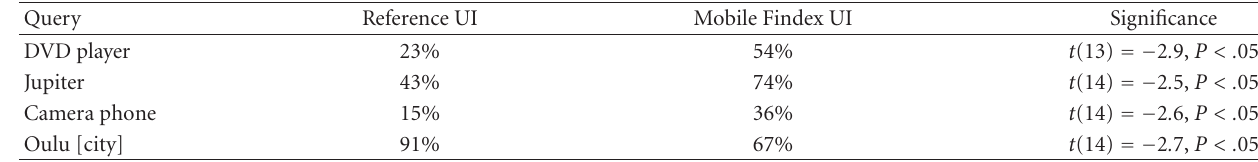
Table 2: Task-specific precision and